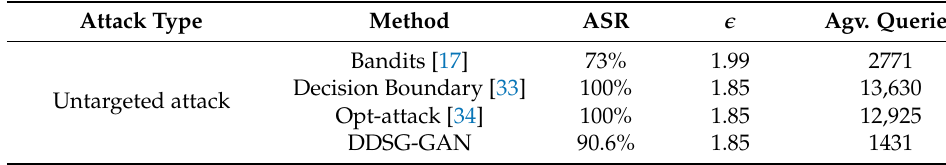
Table 6. Experimental results of untargeted attack under l 2